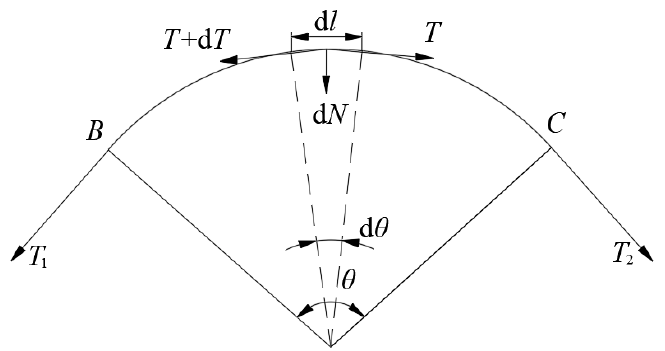
Figure 4. Schematic diagram of contact section between main cable and cable saddle.